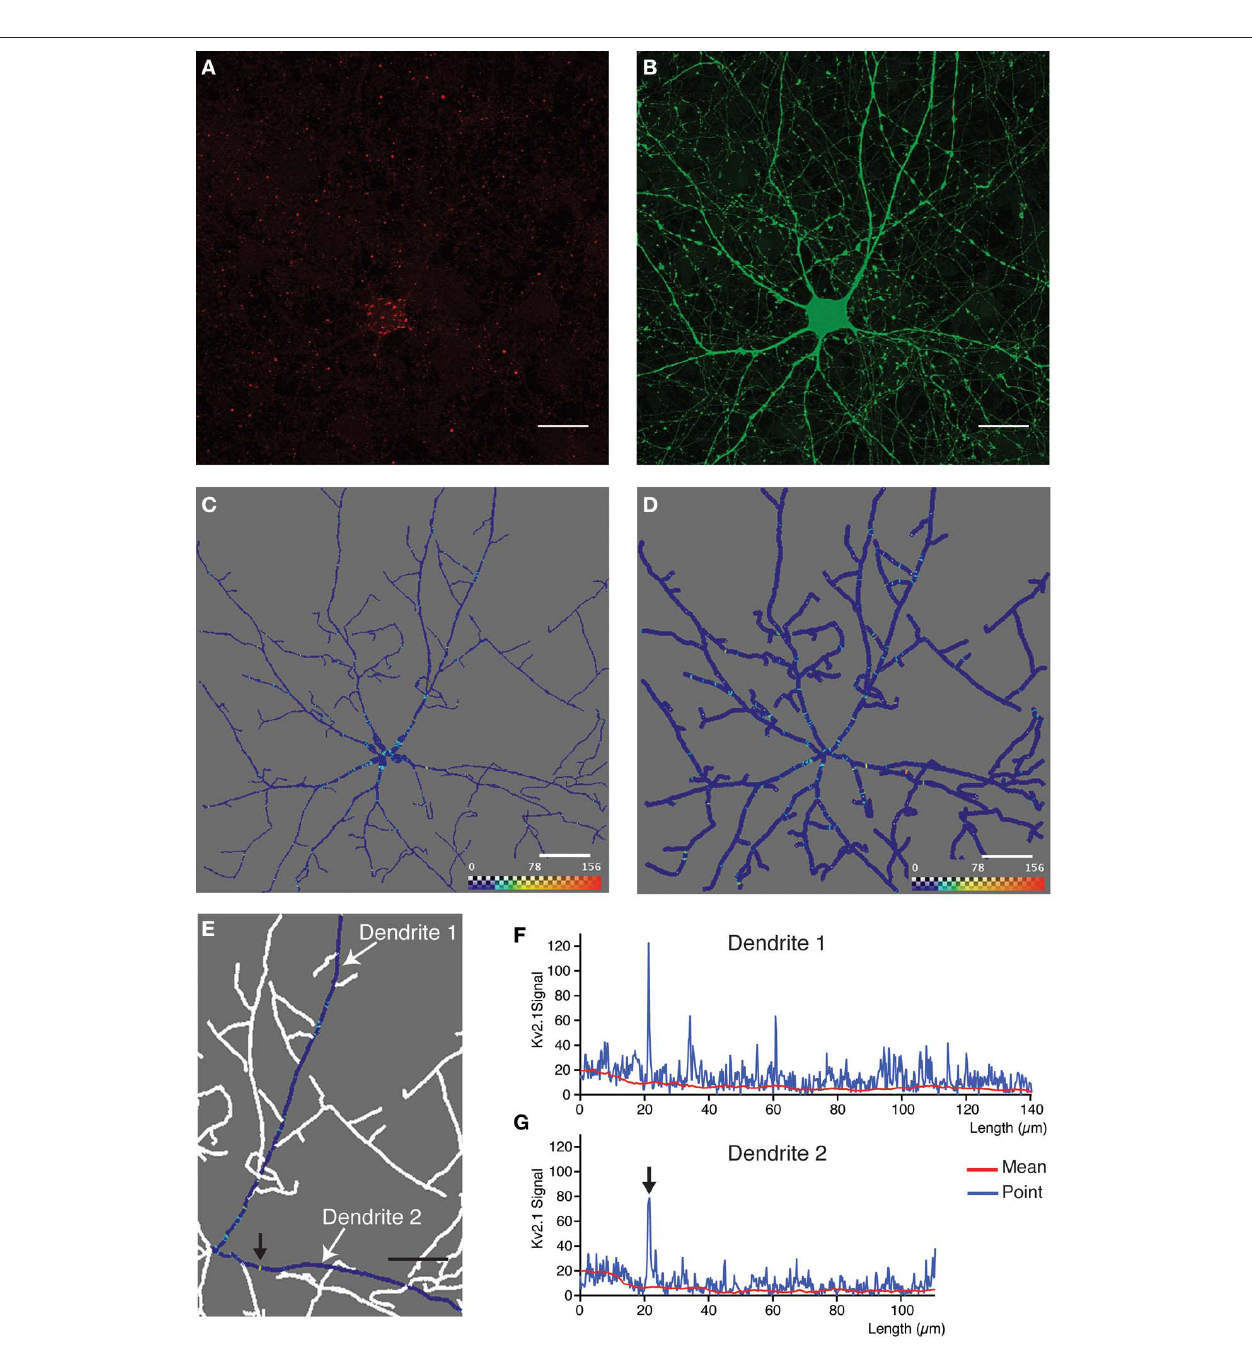
FIGURE 4 | Quantitative analysis and 3D profiling of endogenous Kv2.1 signal in cultured neocortical neurons. (A,B) Image stacks corresponding to endogenous Kv2.1 signal (A) and morphological label (eGFP expression) (B) . Images are z-projections derived from maximum signal intensity across 36 focal planes generated from data that has been subjected to 2 rounds of blind deconvolution. (C) Two-dimensional snapshot taken from Amira viewer window showing neuronal reconstruction overlaid with 3D ion channel profile derived from point fluorescence values calculated along the dendrite skeleton. The color map has been adjusted to best represent, on a graphical level, the predominant ion channel clusters. Scale bar: 20 μ m. In this case, the skeleton is represented as a true morphological skeleton (incorporating information about the radius of the